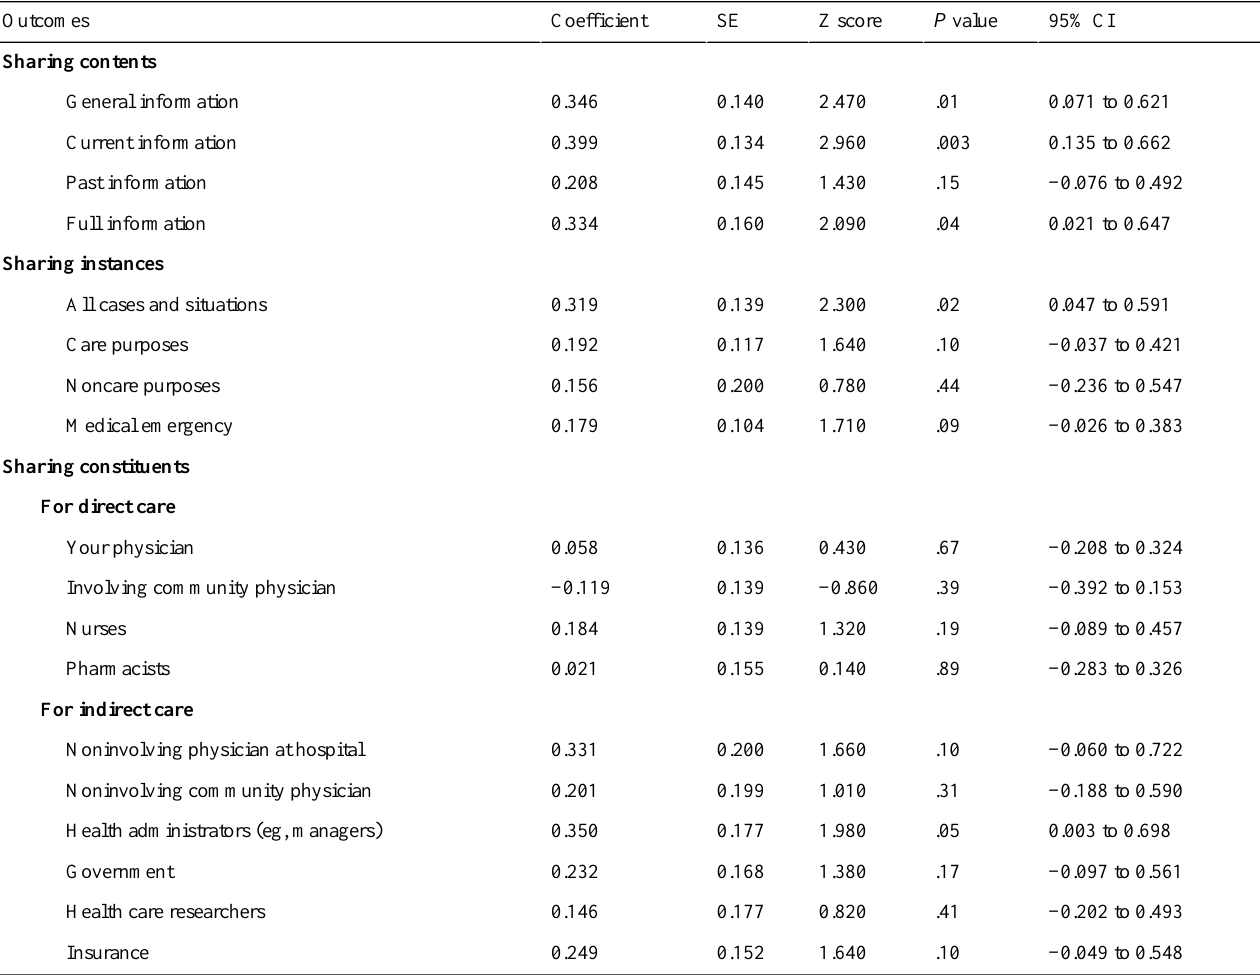
Table 5. Average treatment effects on the treated of daily internet banking